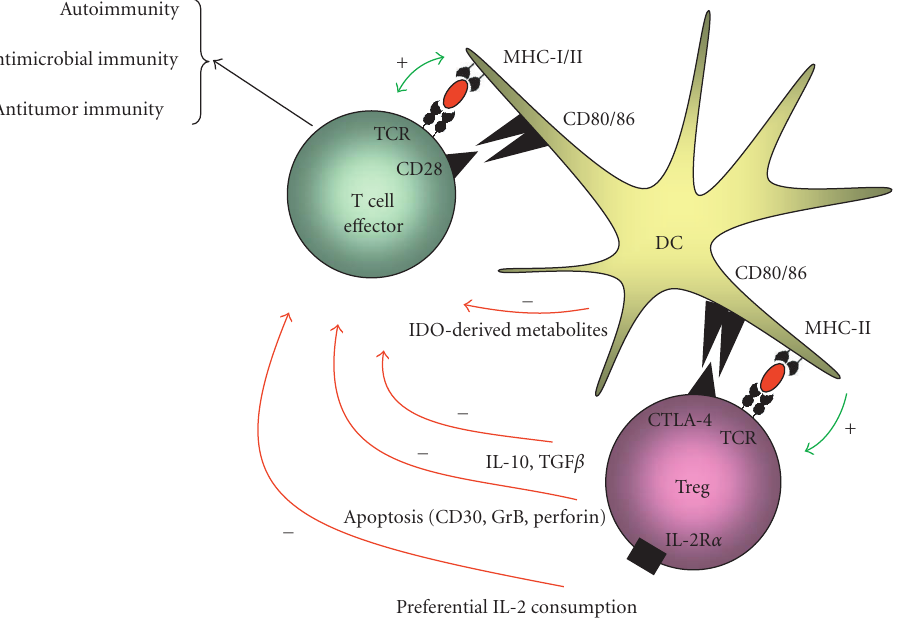
Figure 3: Schematic representation of the regulation of the function of e ff ector T cells by CD4 + CD25 + regulatory T cells. Upon antigen- specific activation by dendritic cells (DCs), CD4 + CD25 + regulatory T (Treg) cells can suppress immune responses through (a) preferential consumption of IL-2 by CD4 + CD25 + regulatory T cells instead of e ff ector T cells, (b) induction of e ff ector T cell apoptosis via CD30/CD30L interactions or perforin/granzyme B (GrB), (c) production of immunosuppressive cytokines IL-10 and TGF- β by CD4 + CD25 + regulatory T cells, and (d) production of immunosuppressive tryptophane metabolites as a result of upregulation of indoleamine-2,3-dioxygenase (IDO) in